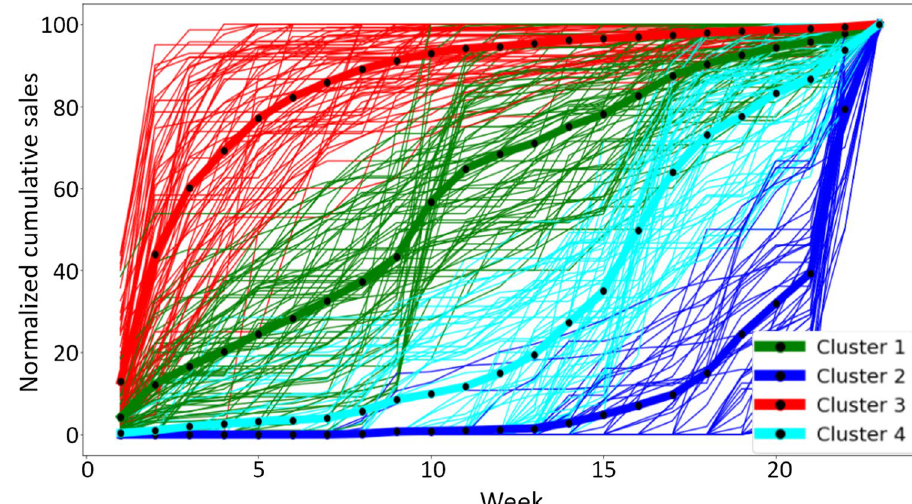
Fig. 8 An example of the 4 clusters obtained from the sales profiles